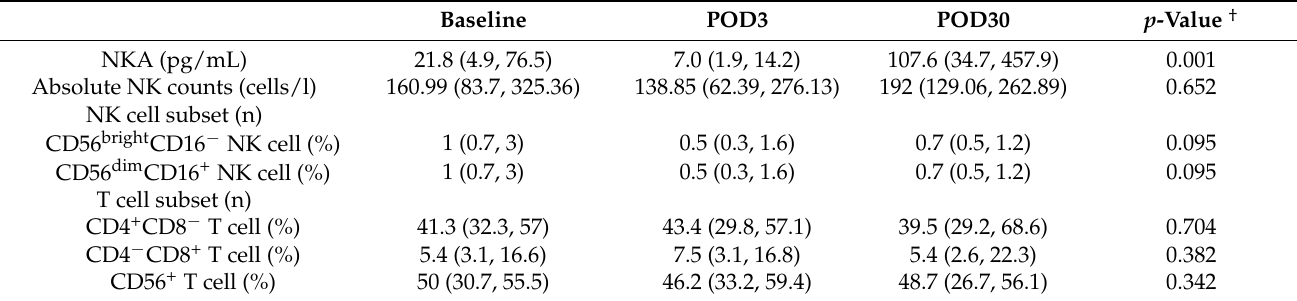
Table 2. NKA status and distribution of NK cell and T cell subsets in patients with glioblastoma before and after surgical